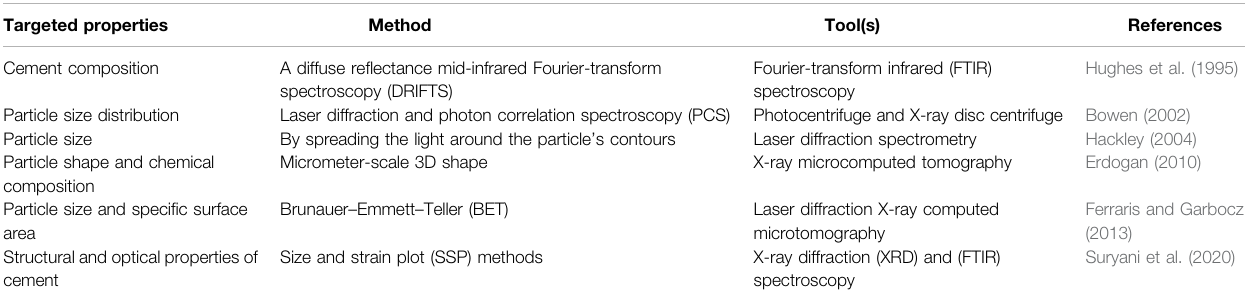
TABLE 2 | Digitalization of cement